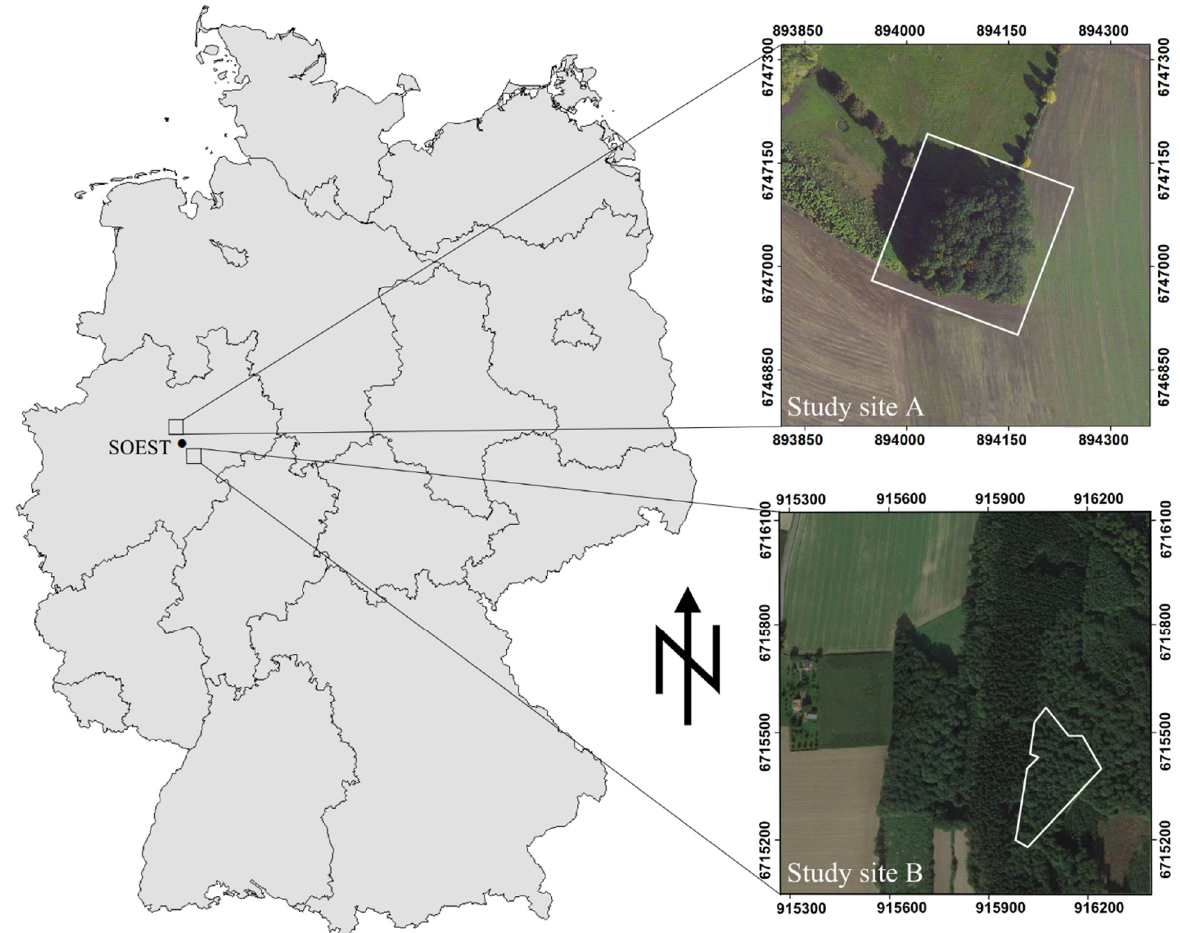
Figure 2. Location map of the study sites in Northrhine Westfalia near the town Soest (Germany). The investigated study sites are outlined in